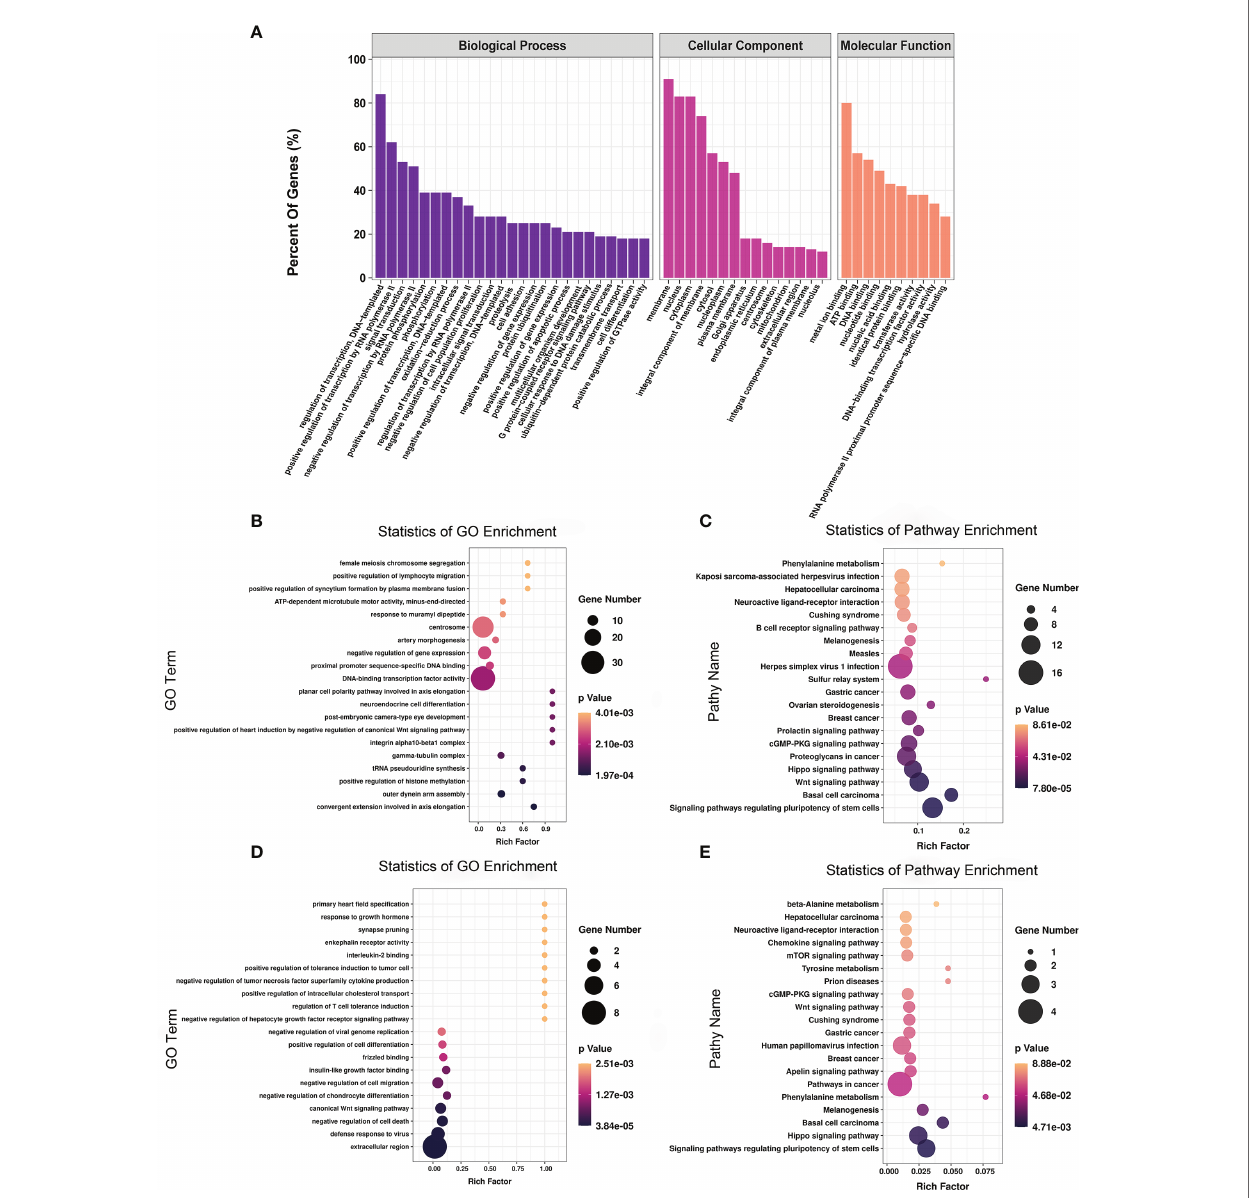
FIGURE 5 | The distribution and functional analysis for differential m6A-modi fi ed mRNAs. GO enrichment (A, B) and KEGG signaling pathway analysis (C) of differential m6A-modi fi ed mRNAs. GO enrichment (D) and KEGG signaling pathway analysis (E) of mRNAs with simultaneous differences in m6A and transcription